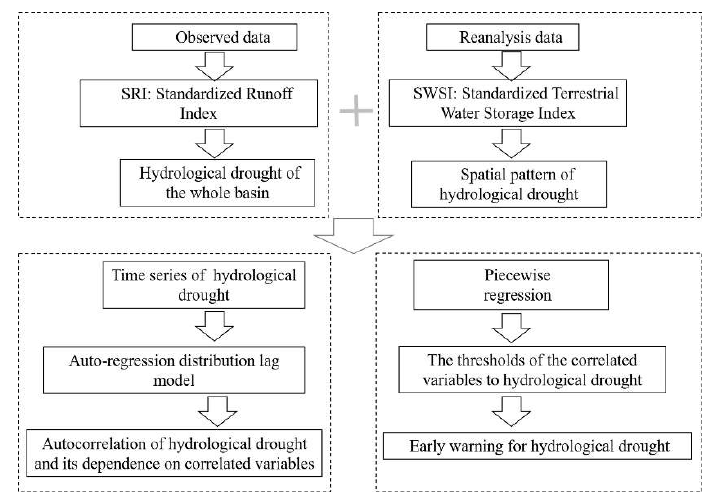
Figure 2. The framework of this study.